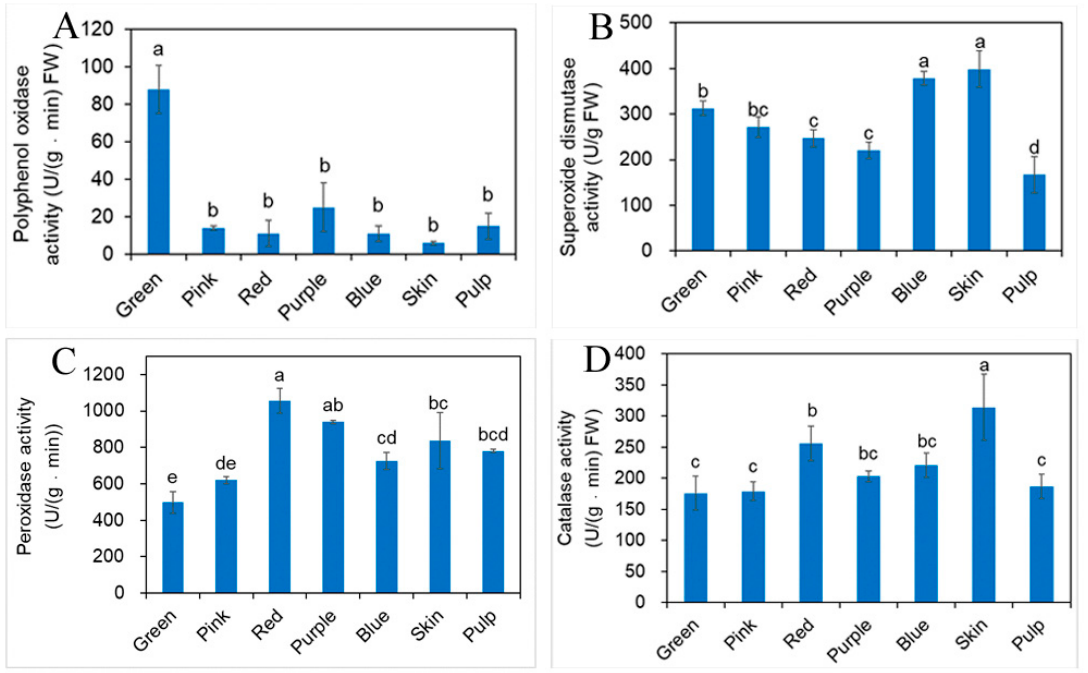
Figure 5. Changes of the contents of antioxidant enzyme activity for blueberry different developmental stages of fruit, skin and pulp. ( A ) Polyphenol oxidase activity; ( B ) superoxide dismutase activity; ( C ) peroxidase activity; ( D ) catalase activity (mean ± SD, n = 3). Bars with different letters in common differ significantly ( p < 0.05).